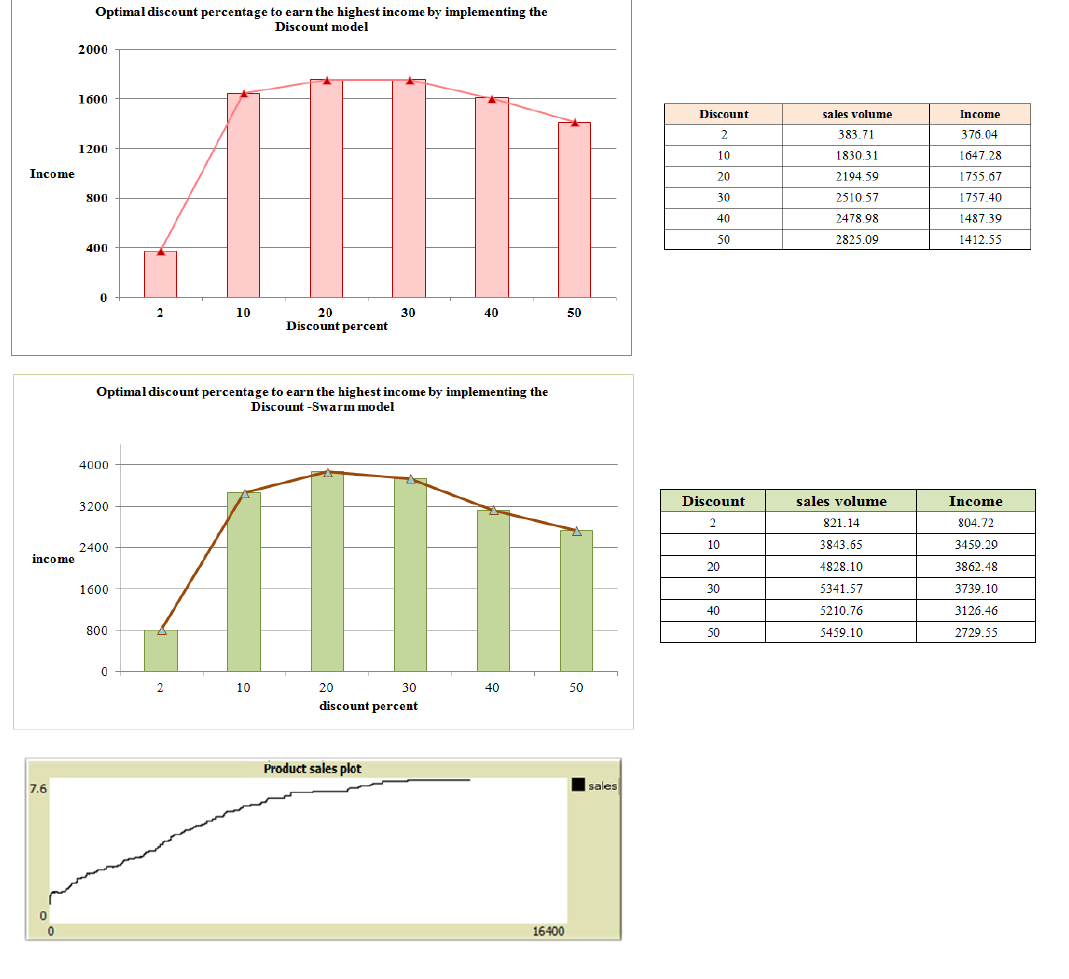
Fig. 11. Customers' IB behavior and optimal discount point for highest